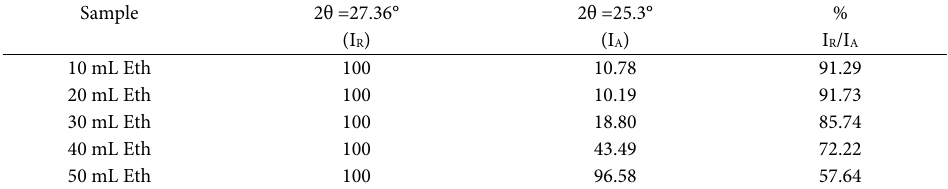
Table 2. Relative intensity of some characteristic peaks of the prepared samples at 600 Sample